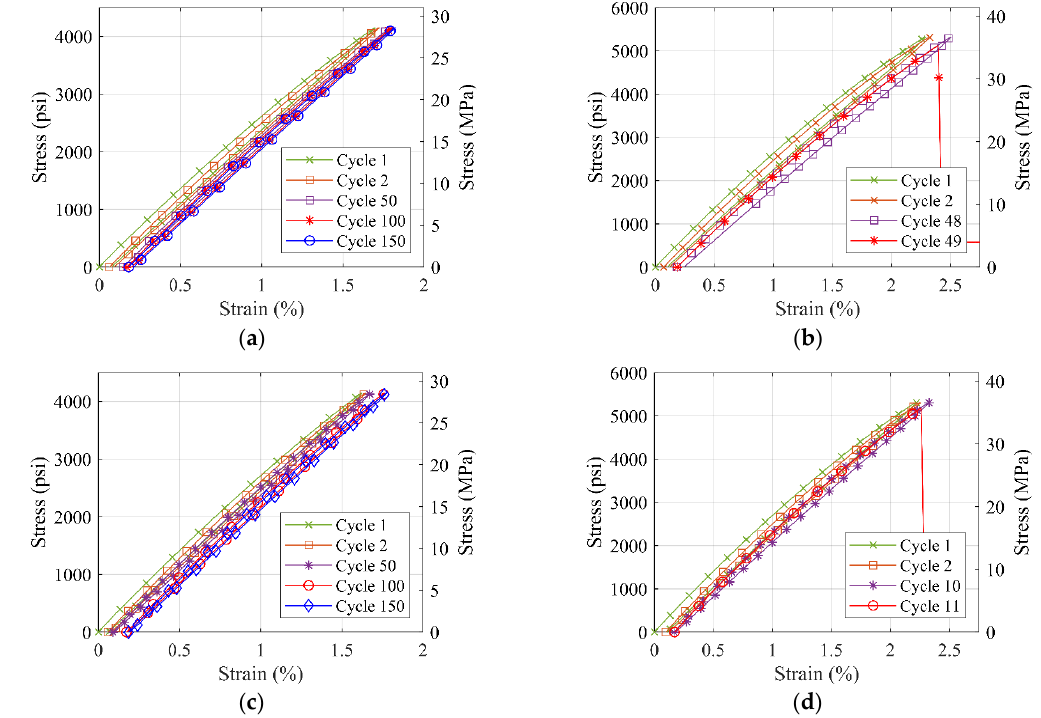
Figure 10. Stress-strain curve for tensile fatigue testing of S1 material with ( a ) 70% of the max load for sample 1 ( b ) 90% of the max load for sample 1 ( c ) 70% of the max load for sample 2 ( d ) 90% of